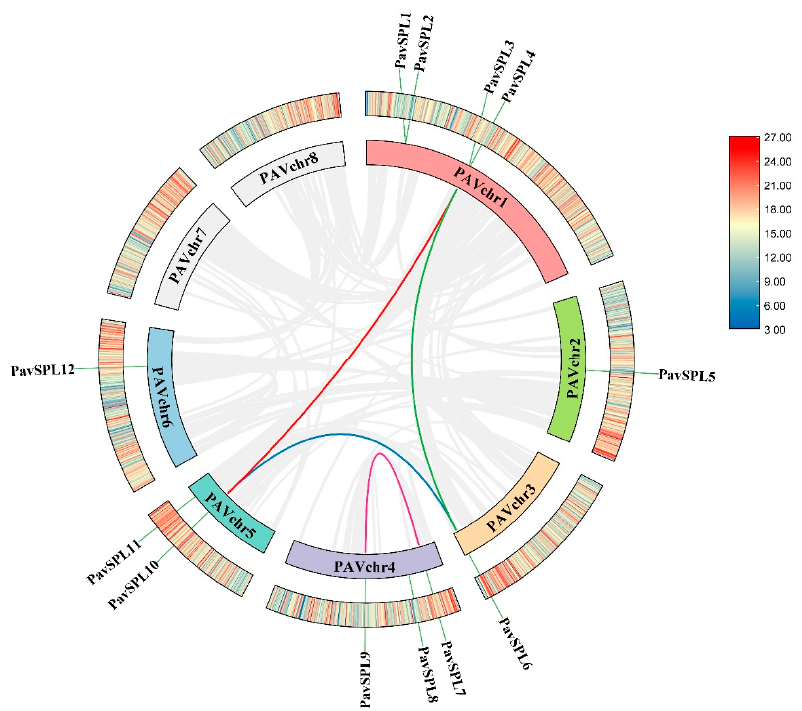
Figure 1. Distribution of the intra-genomic duplications and collinear analysis of PavSPL genes in the sweet cherry. Different color lines represent the segmental duplicated PavSPL genes. The gray line represents all the covariates, and the chromatic line represents the pairwise replication of the SPL gene family. Table 2. Calculation of Ka and Ks ratios of duplicated PavSPL gene pairs.